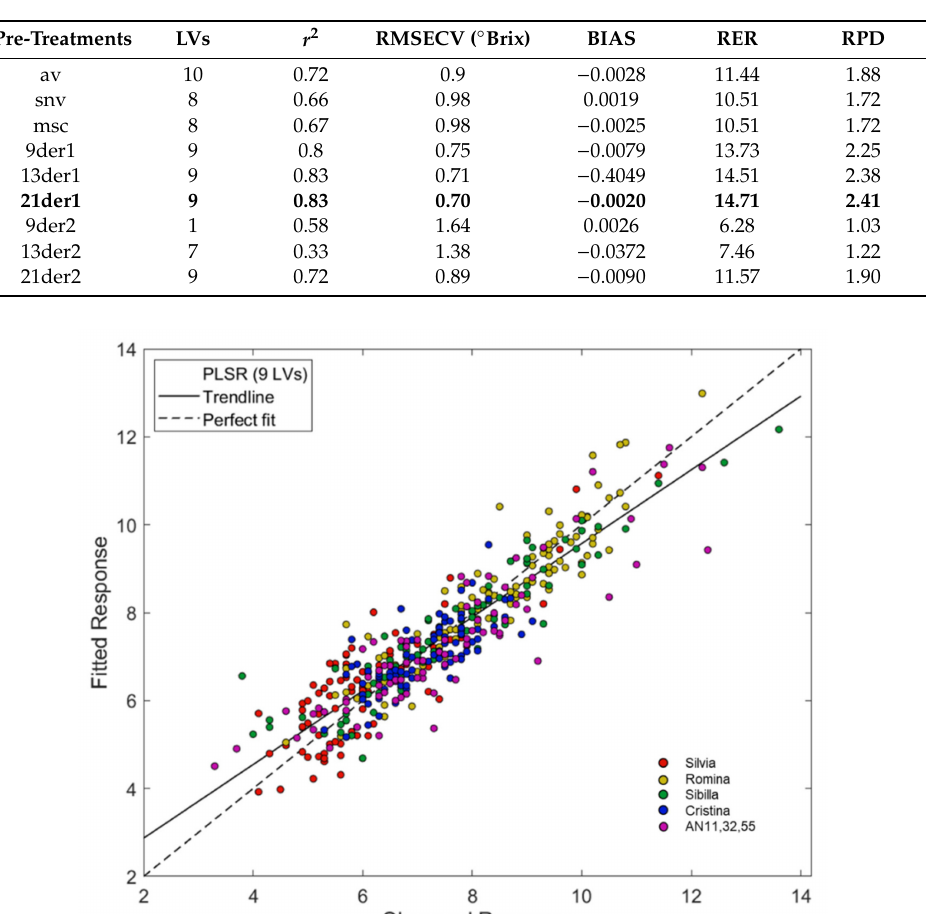
Table 2. Summary of Partial Least Squares Regression (PLS) results for the prediction of soluble solid content ( ◦ Brix). The best PLS model is marked in bold (xder1 = first derivative with x number of smoothing points; xder2 = second derivative with x number of smoothing points; av = average; LVs = Latent Variables; RMSECV = Root Mean Square Error of Cross Validation; RER = Range Error Ratio; RPD = Ratio of Performance to Deviation).